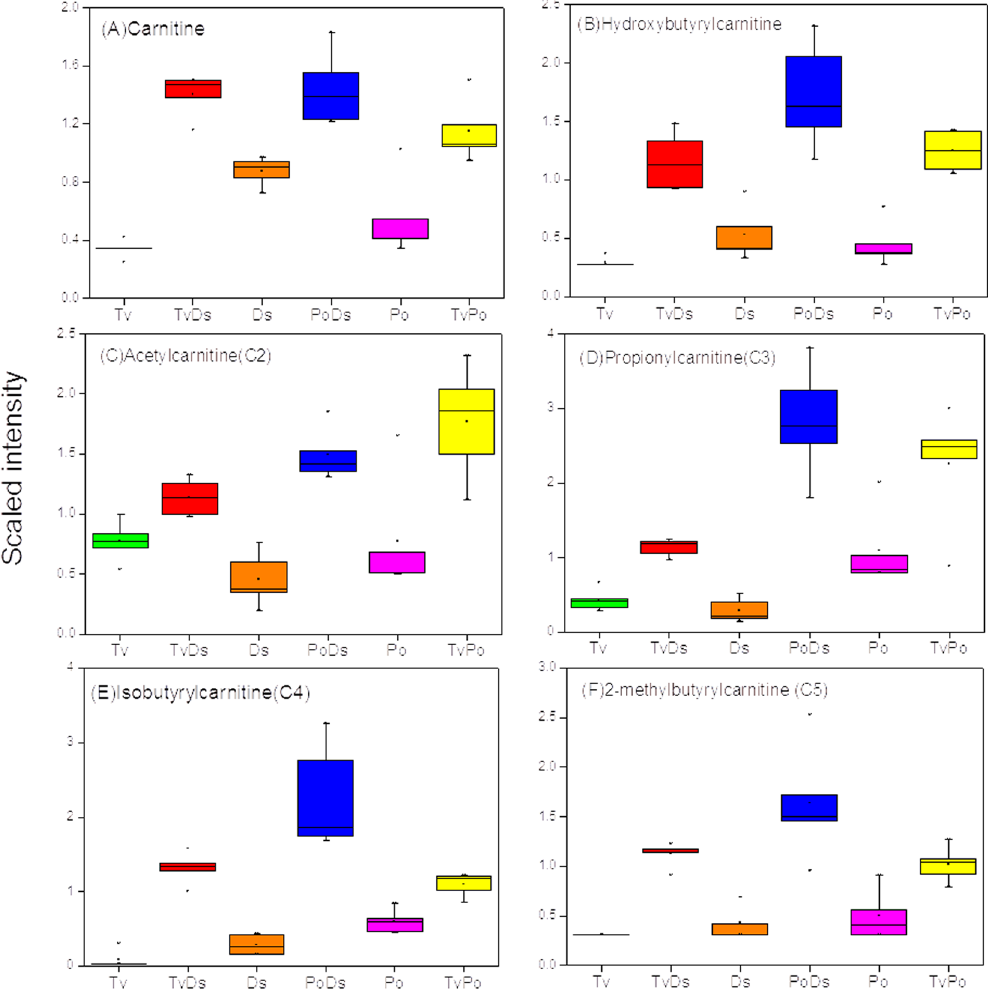
Figure 5. Carnitine esters significantly increase in all interaction zones. ( A ) Carnitine; ( B ) Hydroxybutyrylcarnitine; ( C ) Acetylcarnitine; ( D ) Propionylcarnitine; ( E ) isobutyrylcarnitine; ( F )